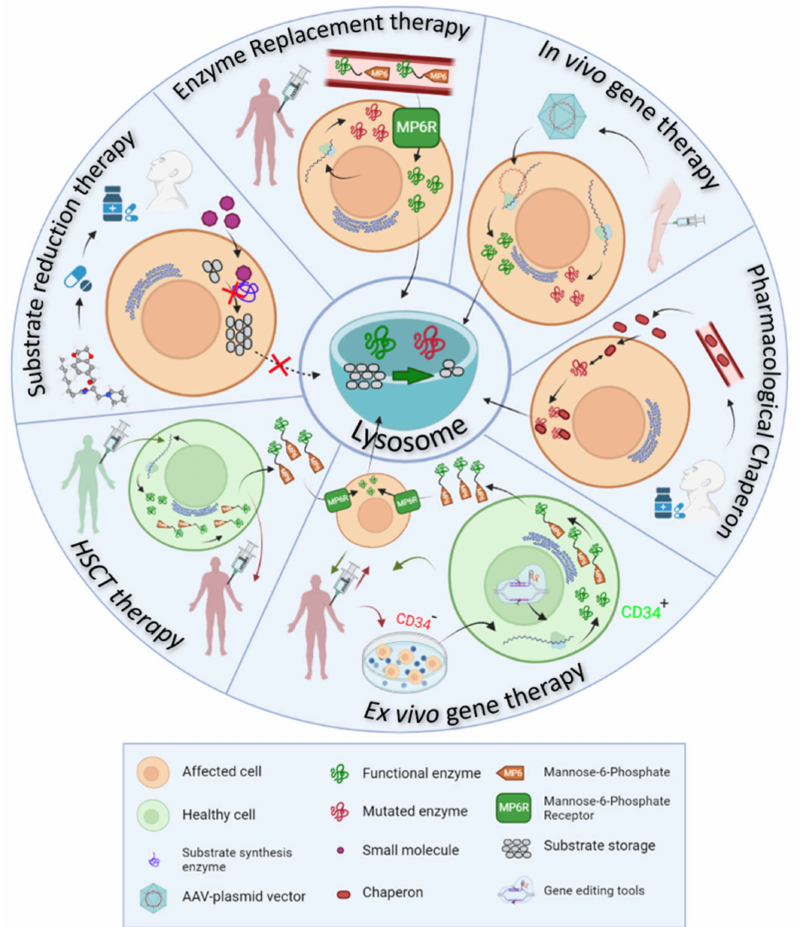
Figure 2. Therapeutic approaches in LSDs. Physiology of the lysosome is at the basis of the ther- apeutic strategies proposed to treat LSDs. All these approaches aim to restore substrate produc- tion/cleavage balance in the lysosome (green semicircle in the center of the image).